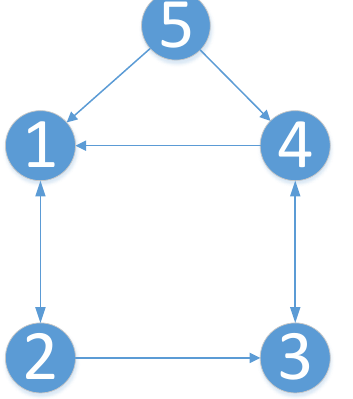
Figure 2. Fixed topology.